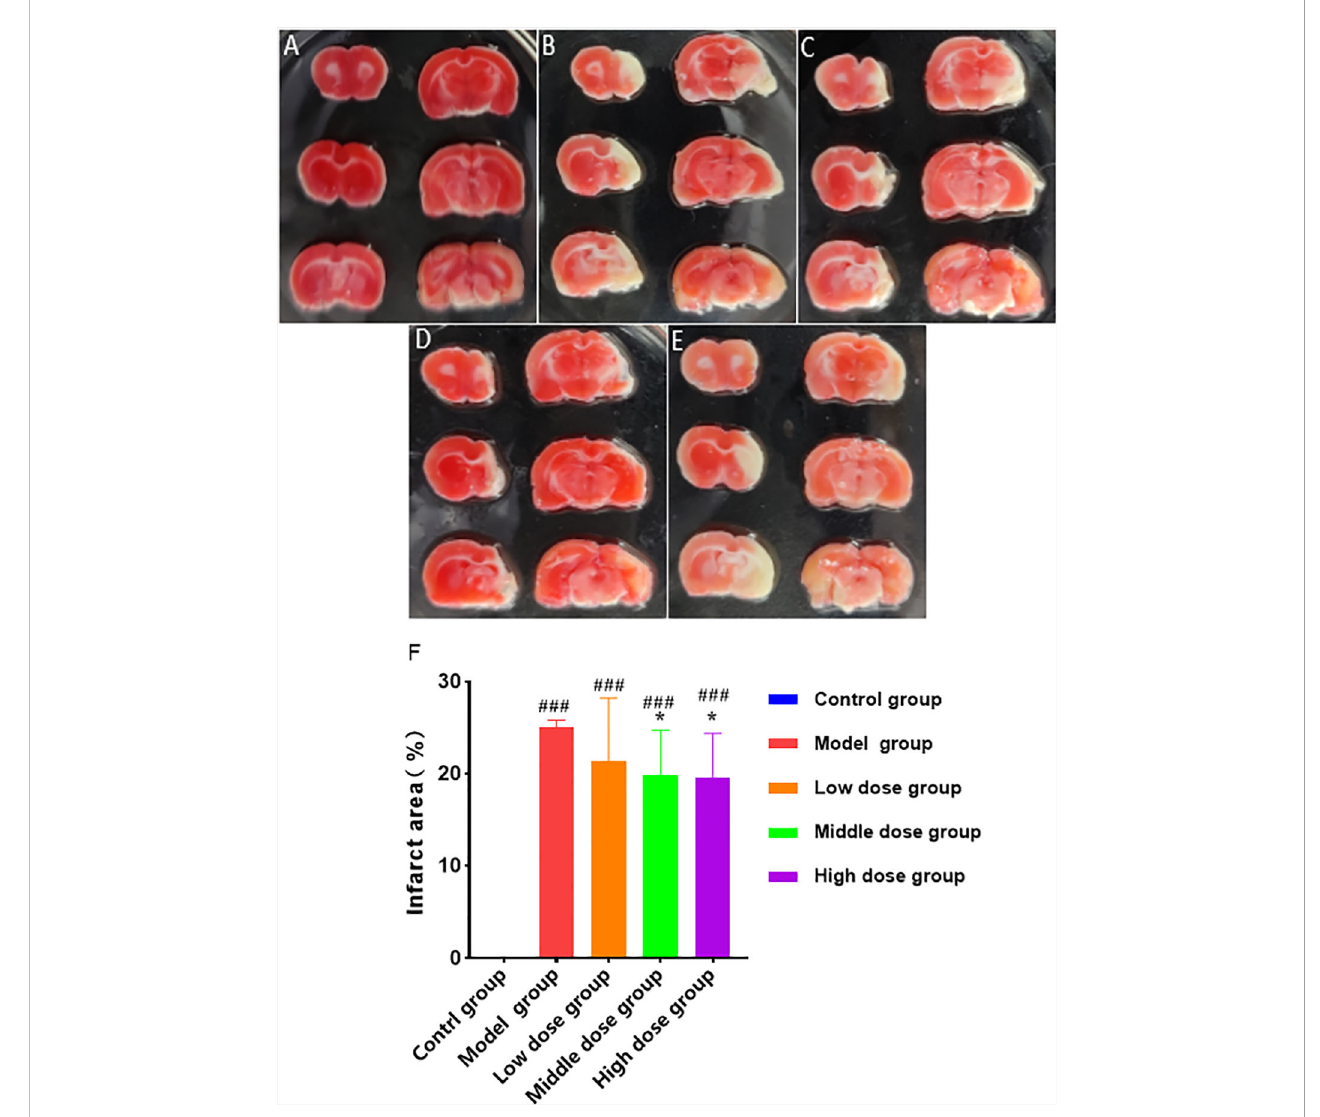
FIGURE 10 Effect of different doses of hUCMSCs on cerebral infarction area of MCAO rats. (A – E) Results are shown for the control group, model control group, low- dose hUCMSCs treatment group, medium-dose hUCMSCs treatment group, and high-dose hUCMSCs treatment group, respectively. (F) The proportion of cerebral infarction area in different hUCMSCs treatment groups. Data are presented as mean ± SD. ### P < 0.001 vs control group; *P < 0.05 vs model